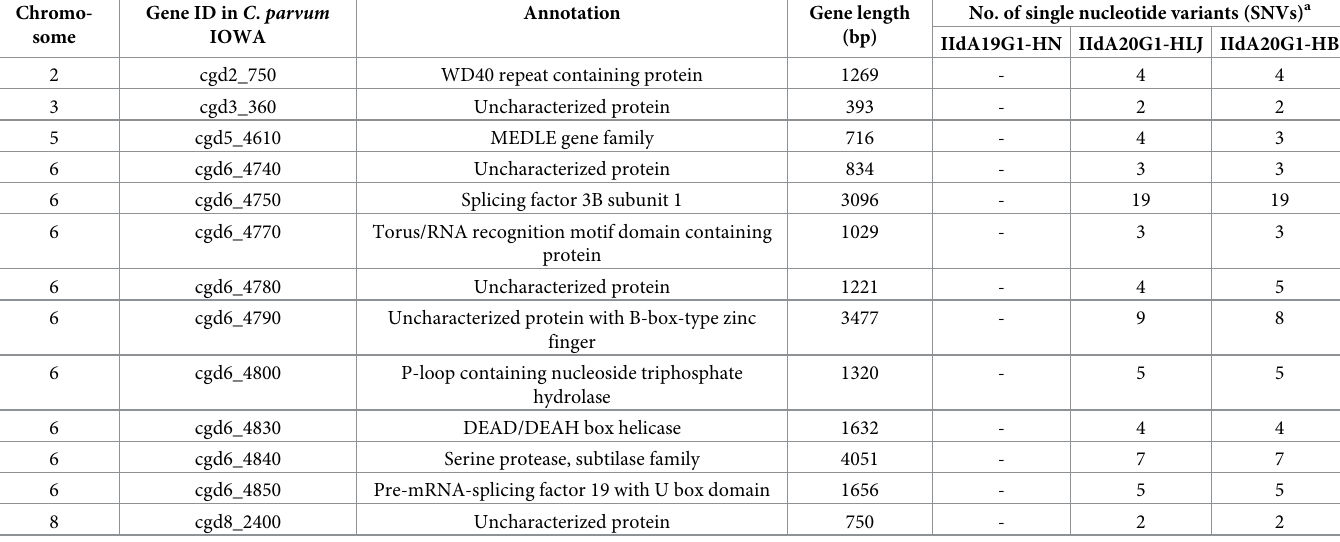
Table 3. Potential virulence-associated genes among four IId Isolates of Cryptosporidium parvum